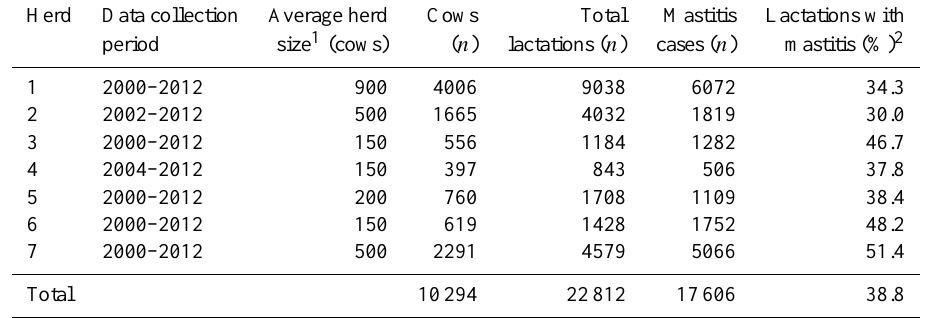
Table 1. Characteristics of seven herds contributing data on mastitis occurrence and economically important production traits. Herd Data collection Average herd Cows Total Mastitis Lactations with period lactations ( n ) cases ( n )